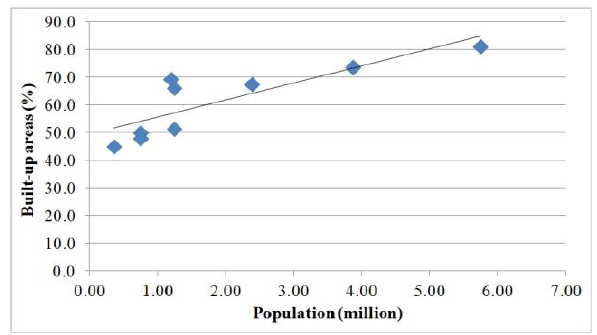
Figure 7. Relationship between the percentage of built-up areas and total employment for 2010 ( R 2 = 0.73)